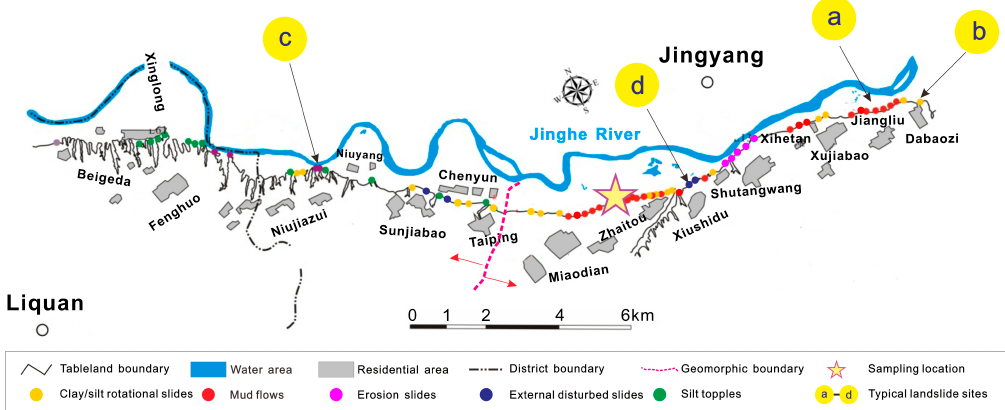
Distribution of loess landslides from 1980 to 2016. Figure 4.